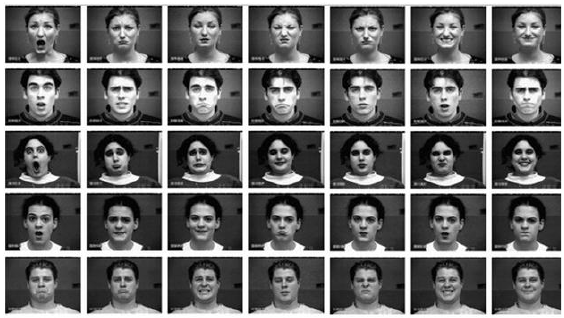
Figure 6. CK+ Dataset, 7 class expressions, number of instances of each expression and percentage .